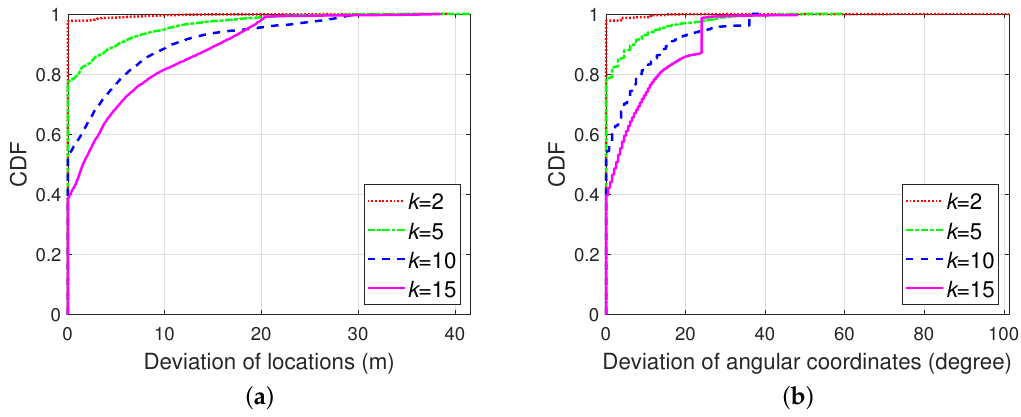
Figure 4. CDF of deviation of: ( a ) retrieved locations with different primary divisions; ( b ) ¯ φ u with different primary divisions.